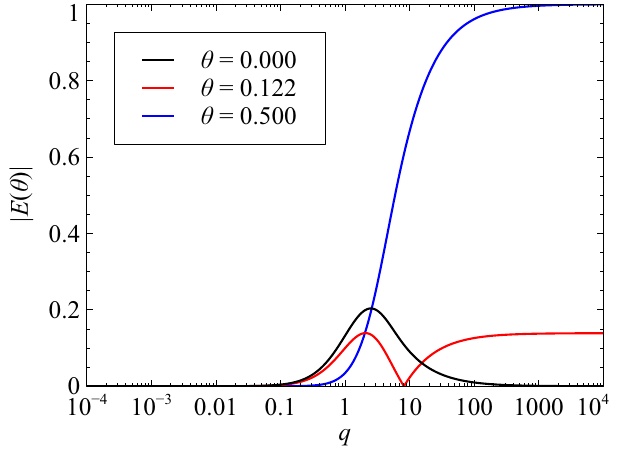
Figure 1. Relation of q and E (θ) .